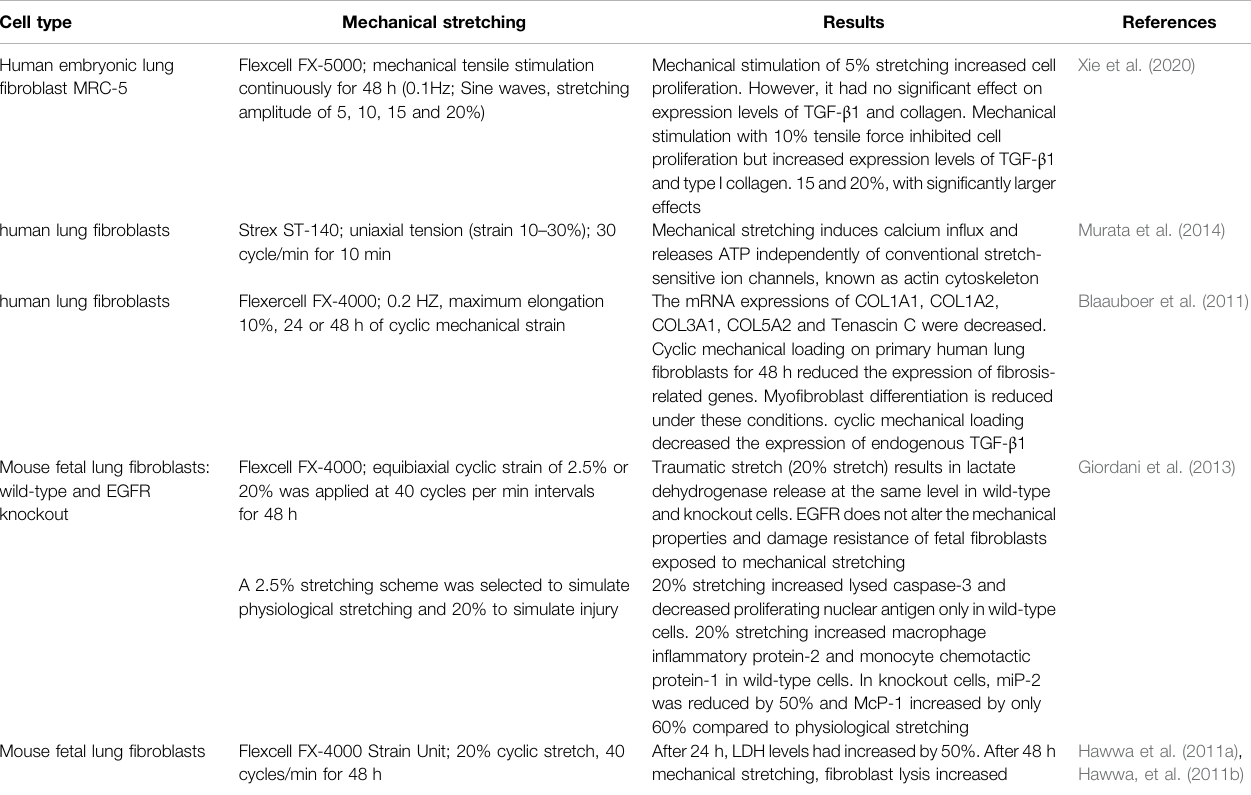
TABLE 2 | Stimulation experiments of lung fi broblasts by mechanical